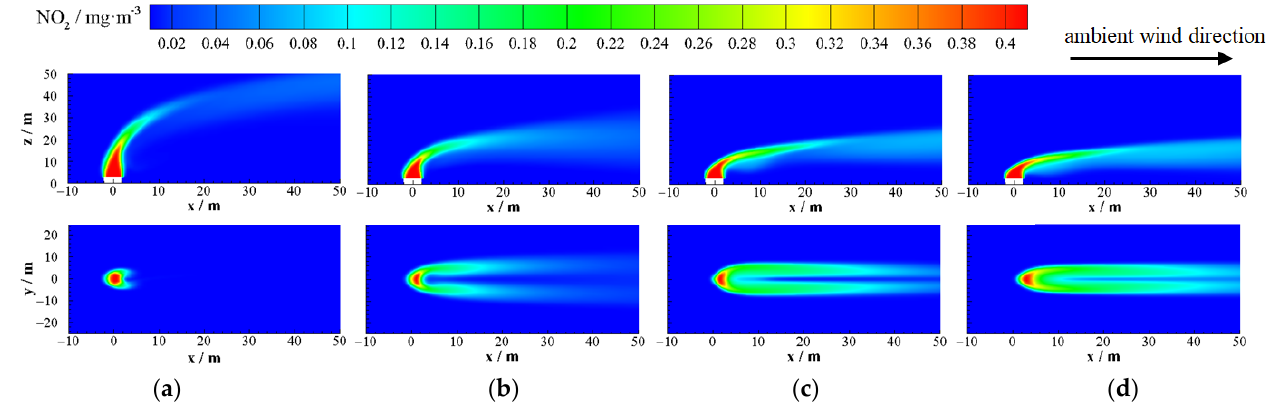
Figure 10. NO 2 distributions of the vertical outlet when V 0 = 6 m/s without considering the ambient wind: ( a ) U = 1 m/s; ( b ) U = 2 m/s; ( c ) U = 3 m/s; ( d ) U = 4 m/s.